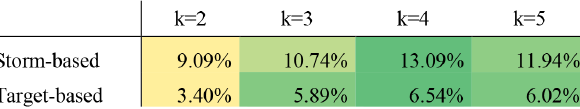
Table 4. The median improvement of the total lifetime MAE when using k = 2–5 instead of k = 1 over the three selected groups of nowcast